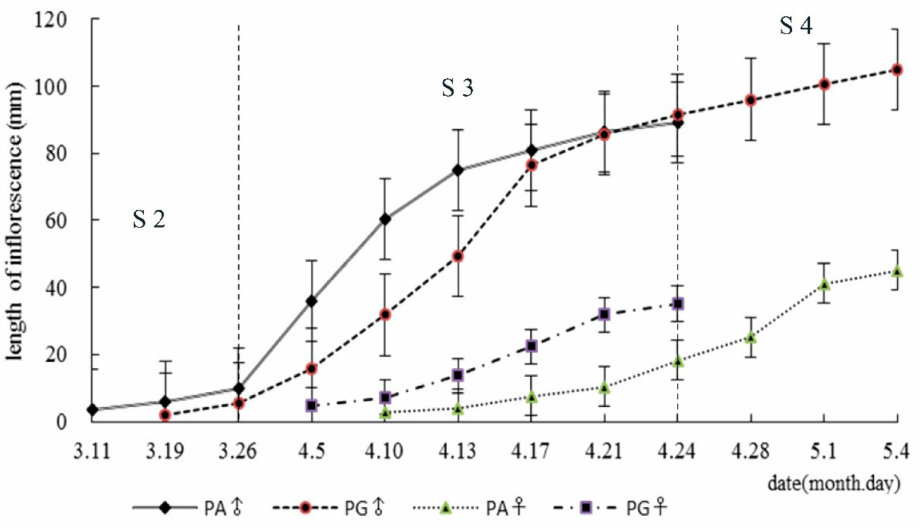
Figure 1. The elongation growth process of male and female inflorescence in two mating types of Cyclocarya paliurus [25]. PG = protogyny; PA =